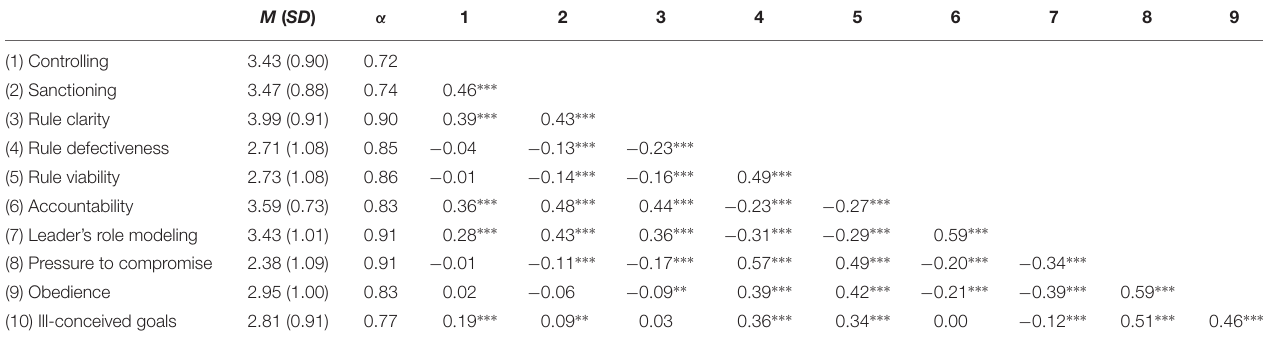
TABLE 3 | Correlation matrix of the GECS factors, means, standard deviations, and Cronbach’s alphas (Sample B, Study 1b). M ( SD ) α 1